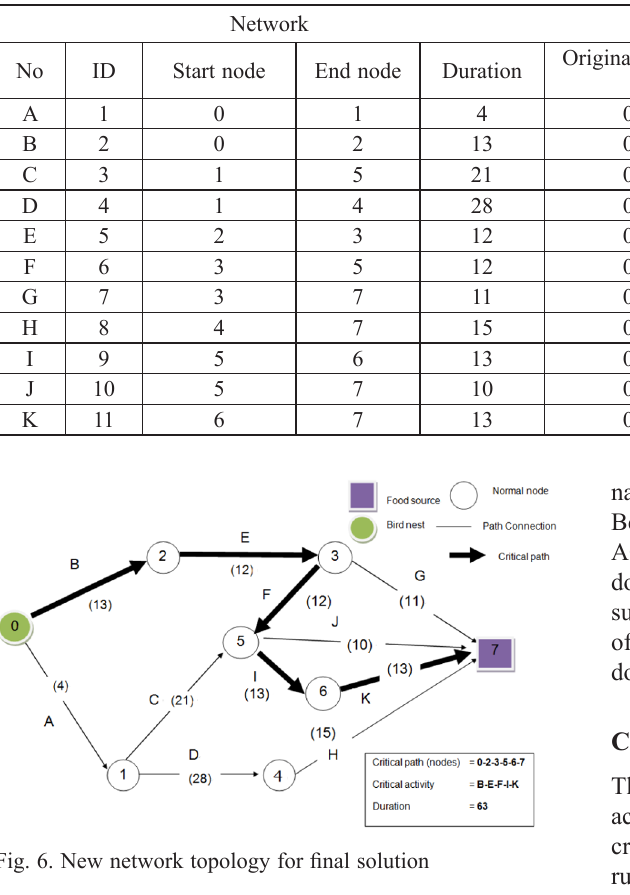
Table 11. Solution of splitting tasks using ACO